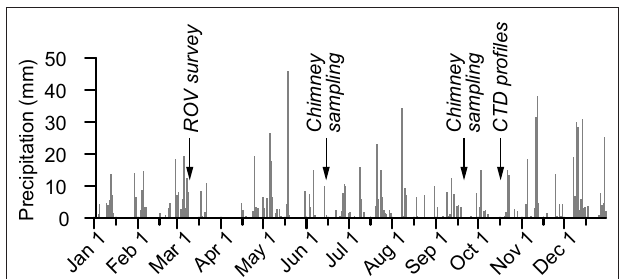
FIGURE 3 | Daily precipitation at the meteorological station Bullet/La Fretaz at 1205m asl in the Jura Mountains (see Figure 1 ) during 2017 (Meteoswiss, 2018) and timing of the giant-pockmark field